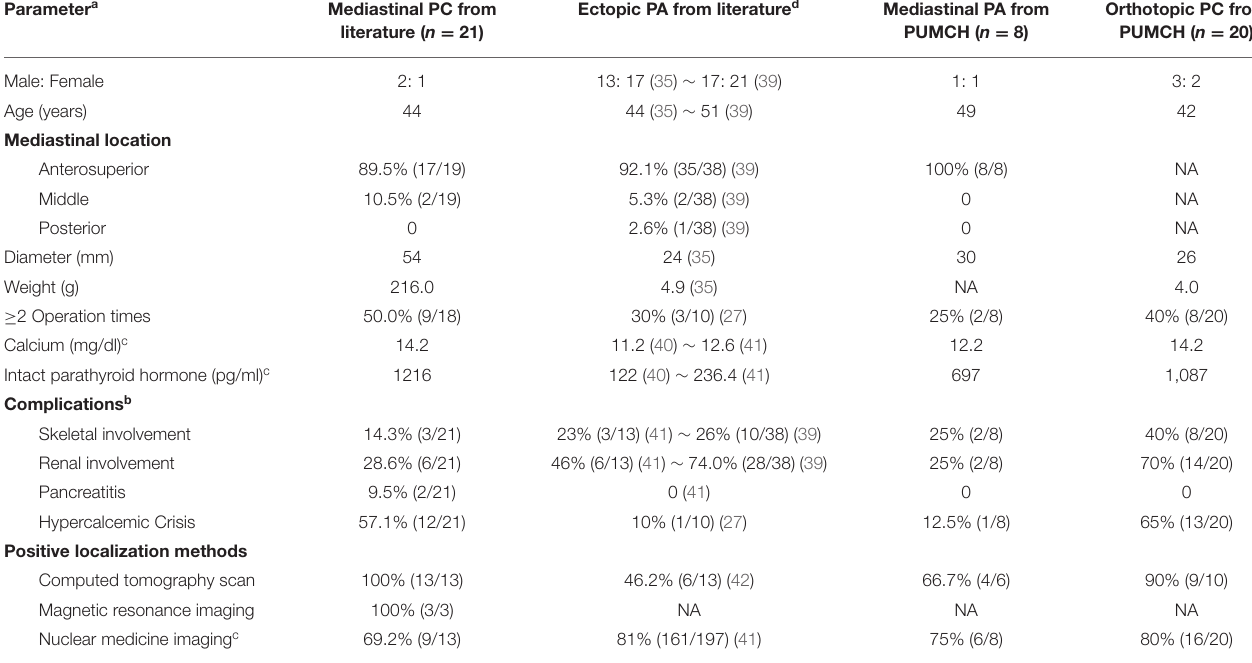
TABLE 2 | Summary of 21 cases with ectopic mediastinal parathyroid carcinomas. Parameter a Mediastinal PC from